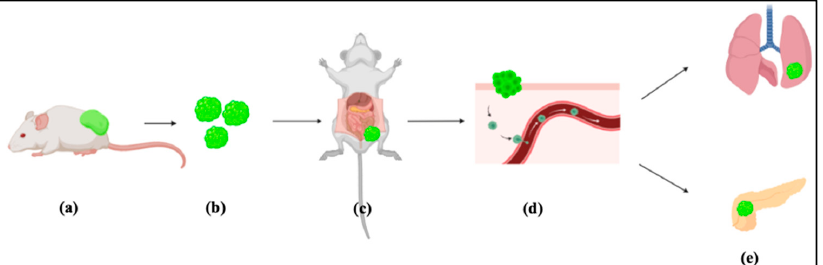
Figure 1. Representative scheme of the metastatic procedure using transplantation method. ( a ) Injected Cancer stem cells (CSCs) subcutaneously and leave it for 4 weeks to form malignant tumor. ( b ) Excised and minimized tumor. ( c ) Transplantation of the minimized malignant tumor in the in the peritoneal cavity. ( d ) CSCs disseminated through blood vessels. ( e ) Disseminated CSCs reached the organs and colonized.